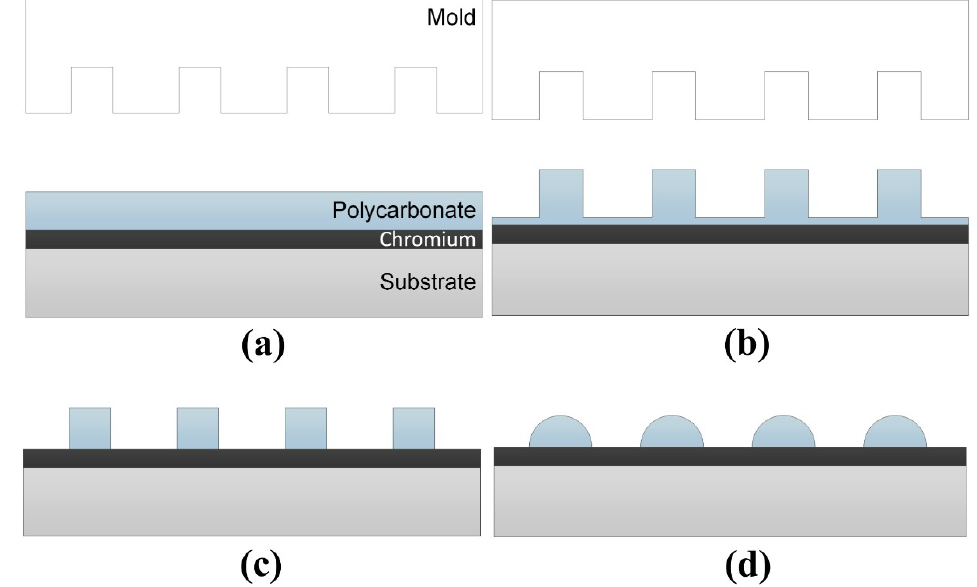
Figure 1. A schematic of polycarbonate nanoimprint and thermal annealing: ( a ) Polycarbonate resist on a chromium layer; ( b ) thermal nanoimprint to form polycarbonate nanostructures; ( c ) oxygen reactive-ion etching (RIE) to remove the residual layer after nanoimprinting; ( d ) annealing of polycarbonate nanostructures on a hot plate at elevated temperatures to induce polymer reflow.